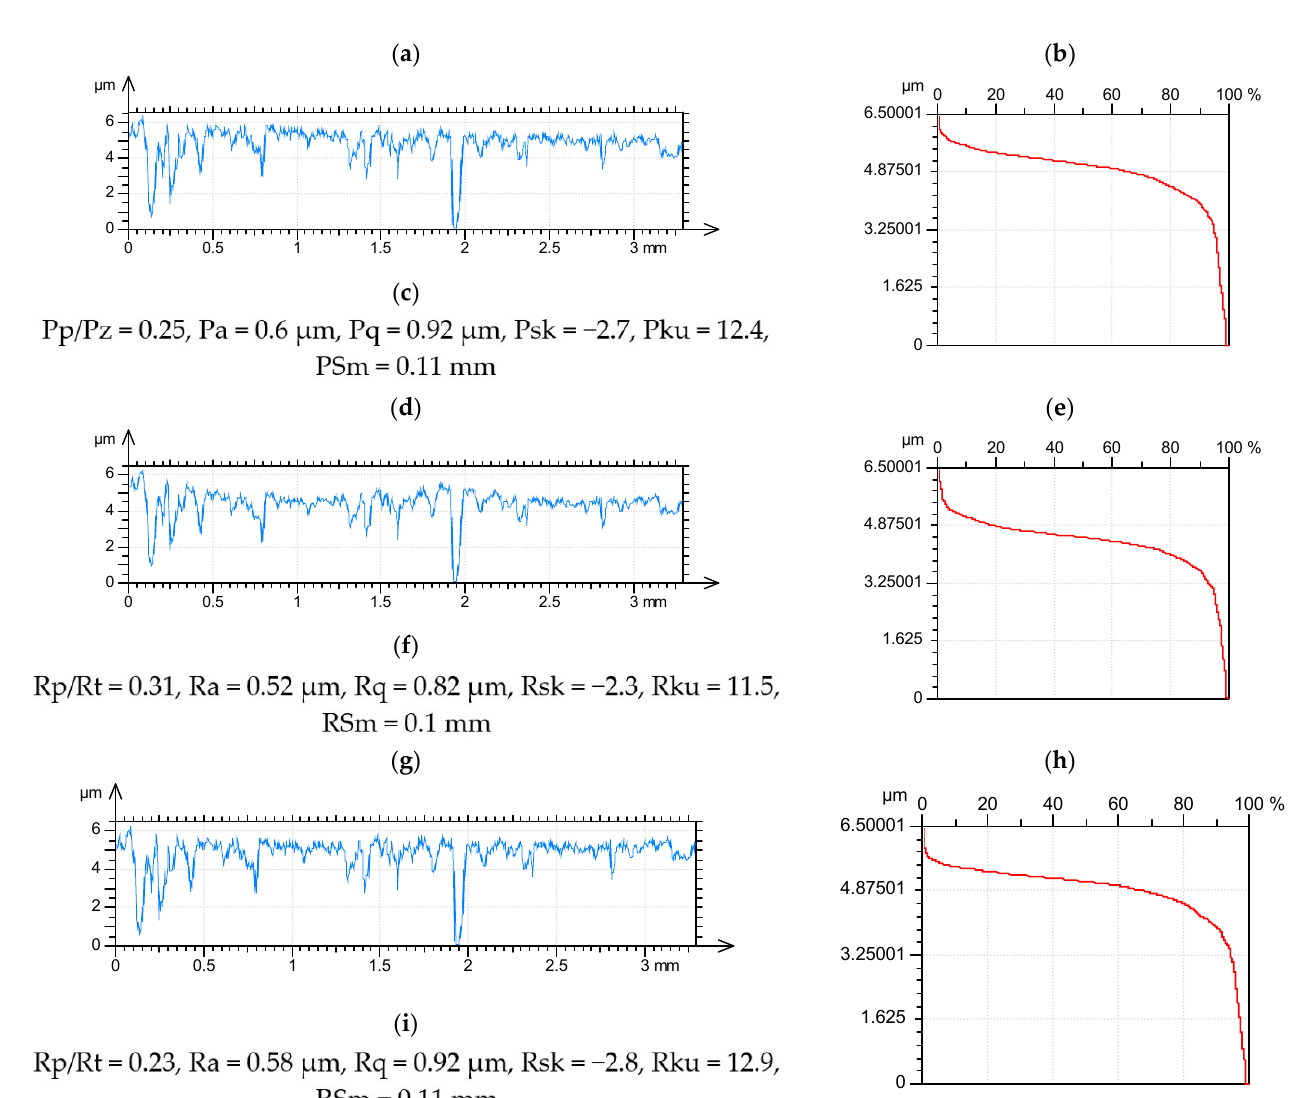
Figure 8. Profiles ( a , d , g ), material ratio curves ( b , e , h ) and selected parameters ( c , f , i ) of the two- process random profile ( a – c ), after application of the Gaussian ( d – f ) and robust Gaussian filter of 0.8 mm cut-off ( g – i ).